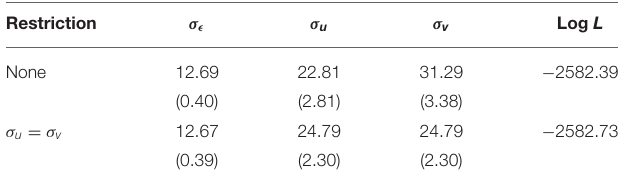
and that all three are normally distributed as N(0, σ 2 ǫ ), N(0, σ 2 ), respectively. and N(0, σ 2 v